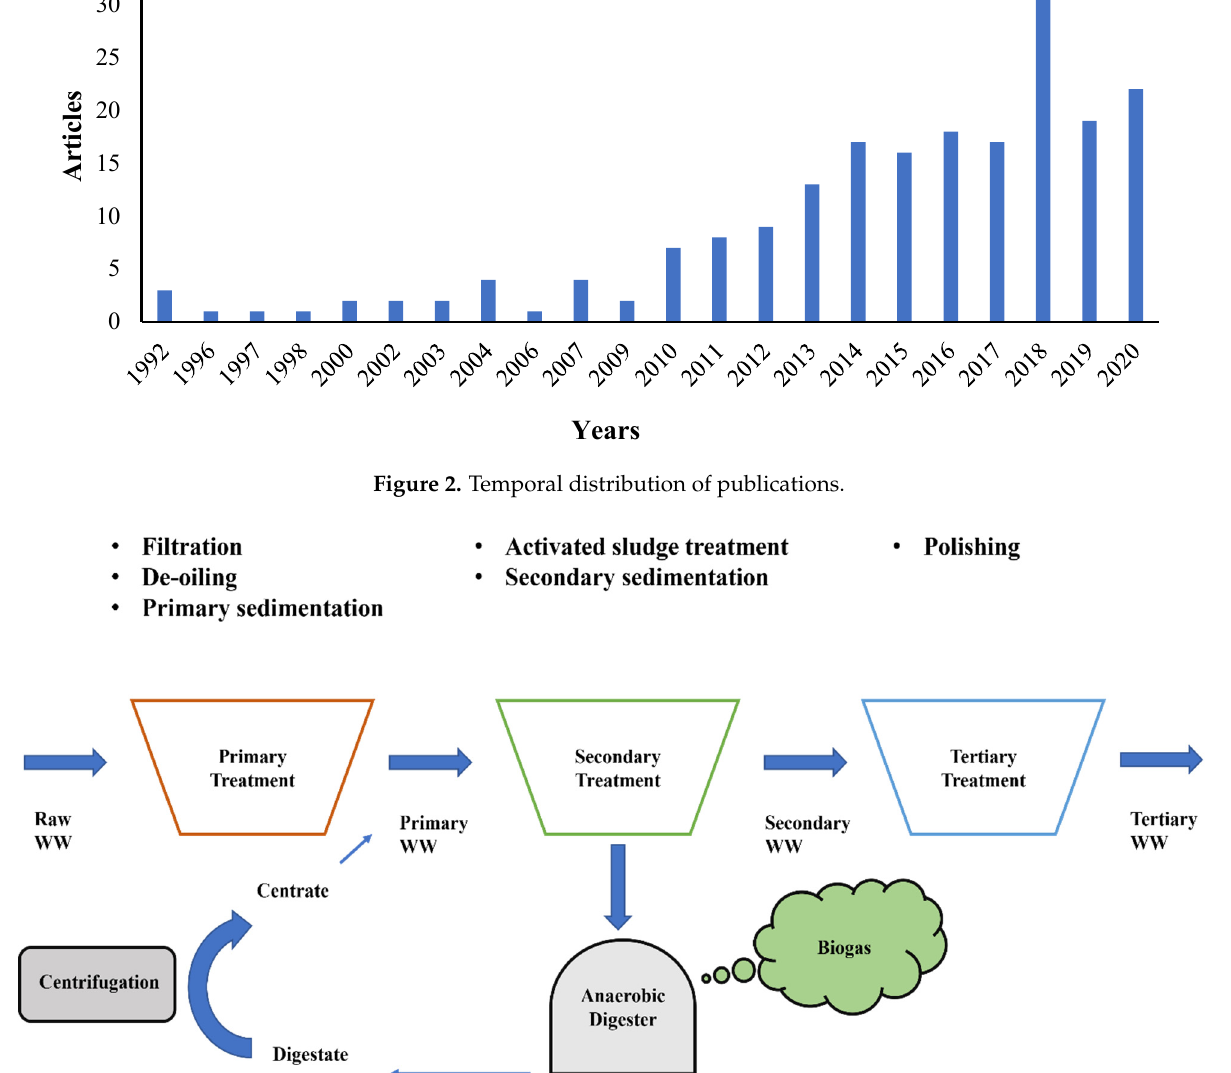
Figure 3. Different phases of wastewater treatment .